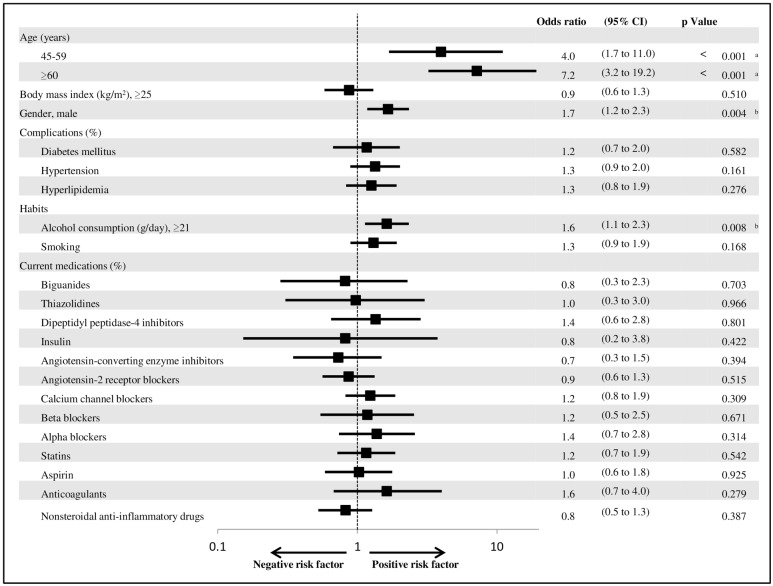
Multivariate predictors of colorectal neoplasia analyzed using a multiple logistic regression analysis.The plot shows the odds ratios (black squares), and 95% CIs (horizontal lines). P-values show the interaction between the prevalence of colorectal neoplasia and any subgroup variable. a. Significant risk factor of colorectal neoplasia by the Pearson χ2 test (P < 0.001). b. Significant risk factor of colorectal neoplasia by the Pearson χ2 test (P < 0.01).